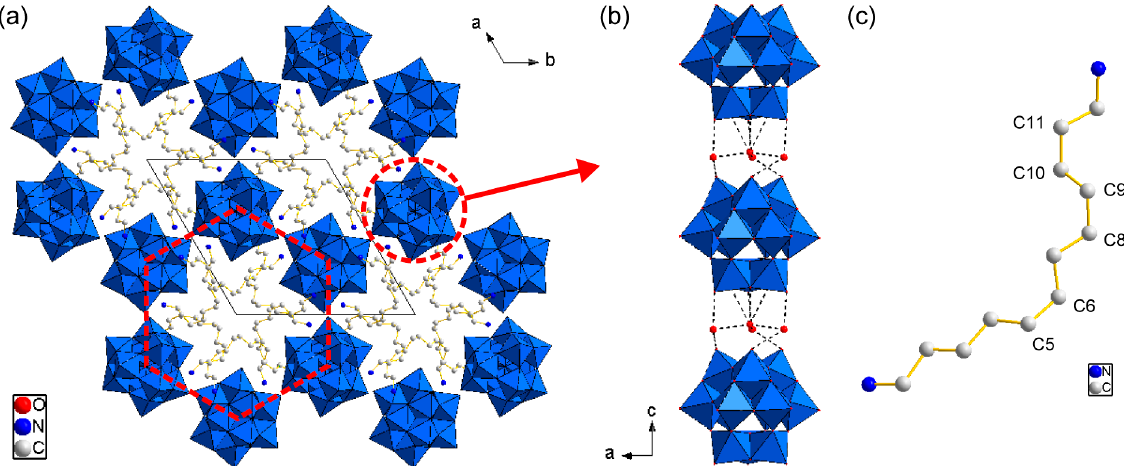
Figure 4. Crystal structure of C 12 N 2 -H 2 W 12 hybrid crystal obtained using “Route 3” (C: gray, N: blue, O: red; and H 2 W 12 anions depicted by polyhedral representation). H atoms were omitted for clarity. ( a ) Packing diagram projected along the c -axis. A honeycomb-like arrangement of H 2 W 12 anions is highlighted by a red broken hexagon; ( b ) molecular arrangement of H 2 W 12 anions and water molecules of crystallization (1D H 2 W 12 -H 2 O chain) viewed along the b -axis, with O · · · O short contacts represented by black broken lines; and ( c ) molecular conformation of C 12 N 2 cation. C atoms relevant to gauche conformation are numbered.